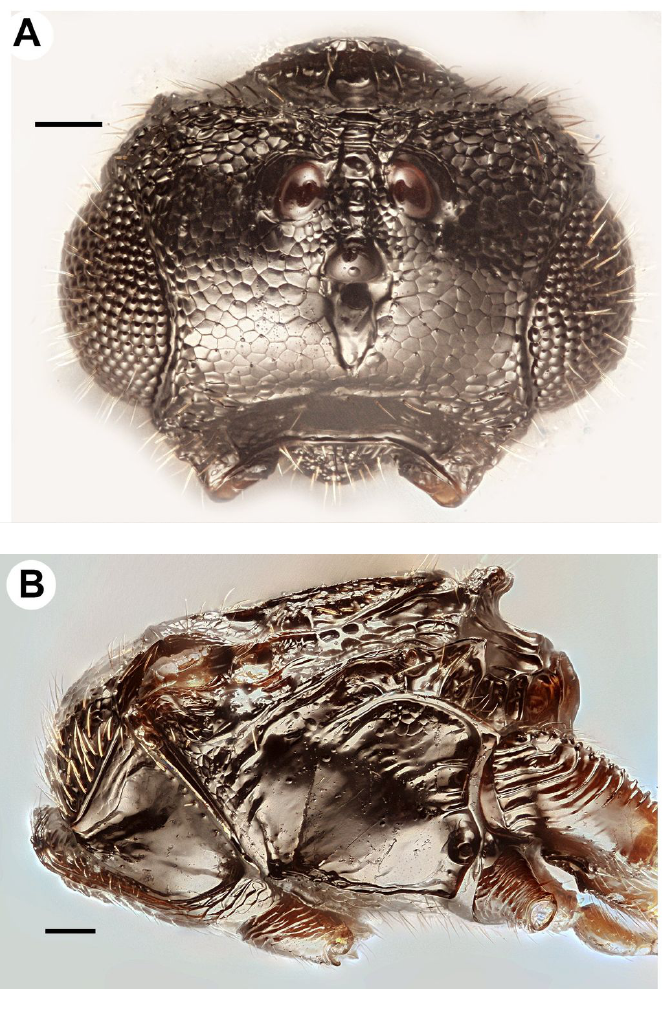
muscle site of insertion: NOT CODED. S1 length vs. shortest width: NOT CODED. Transverse carina of petiole count: present (Fig. 2a). Transverse carina on petiole shape: concave. Basal, longitudinal carinae on syntergum count: more than 5 (Fig. 2b). Transverse sulcus of fi rst metasomal sternum count (S1 count): absent. Waterston's evaporatorium count: present. Waterston's evaporatorium shape medially: not paired,